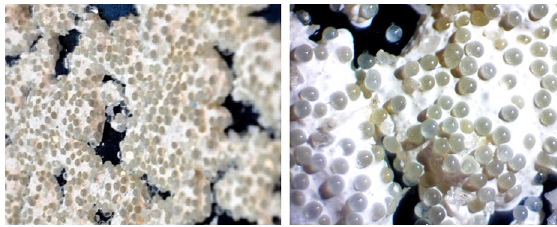
Figure 3. Illustration of a cold plastic structural marking (laboratory